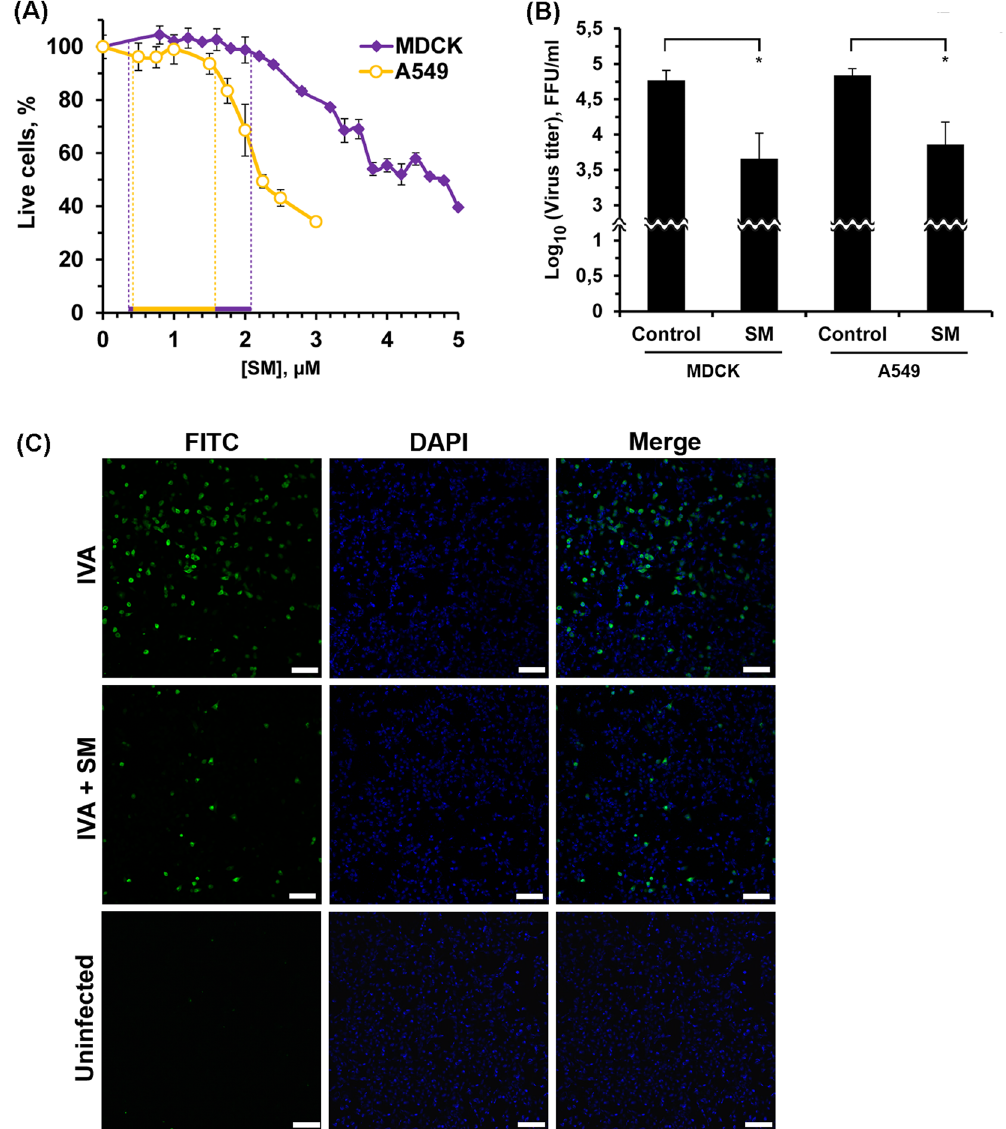
Figure 2. SM reduces IVA replication. ( A ) Dose response curves of SM for MDCK and A549 cell lines. Cells were incubated with increasing concentrations of SM for 24 h. After incubation, cell viability was measured by MTT assay. The results are expressed as a percentage of viable cells observed after treatment with compounds vs control cells (100%) incubated in the presence of 0.1% DMSO. The data are obtained from at least three independent experiments done in triplicate. Dashed line indicates the nontoxic span of SM concentrations. ( B ) Effect of SM on IVA reproduction on different epithelial cell lines. MDCK and A549 cells were infected with IVA at MOI 0.01. After 1 h adsorption at standard conditions, the monolayers were washed twice with PBS and incubated at standard conditions in fresh infection medium with SM (1 µ M) for 24 h. Viral yields in supernatants were determined by FFA. Control – untreated IVA-infected cells. SM – SM-treated IVA-infected cells. Error bars represent the standard deviation of three independent experiments performed in triplicate. P value: * < 0.05. (C) Effects of SM on the expression of IVA nucleoprotein (NP) in A549 cells. Confluent A549 cells were infected with IVA (MOI = 0.1) and then treated with SM (1 µ M). At 6 h p.i. the cells were fixed with paraformaldehyde and expression of viral NP protein was detected by IFA (FITC corresponding to NP protein, nuclei were counterstained with DAPI). Cells were viewed using laser scanning confocal microscope with a 10 × objective. Bars, 100 µ